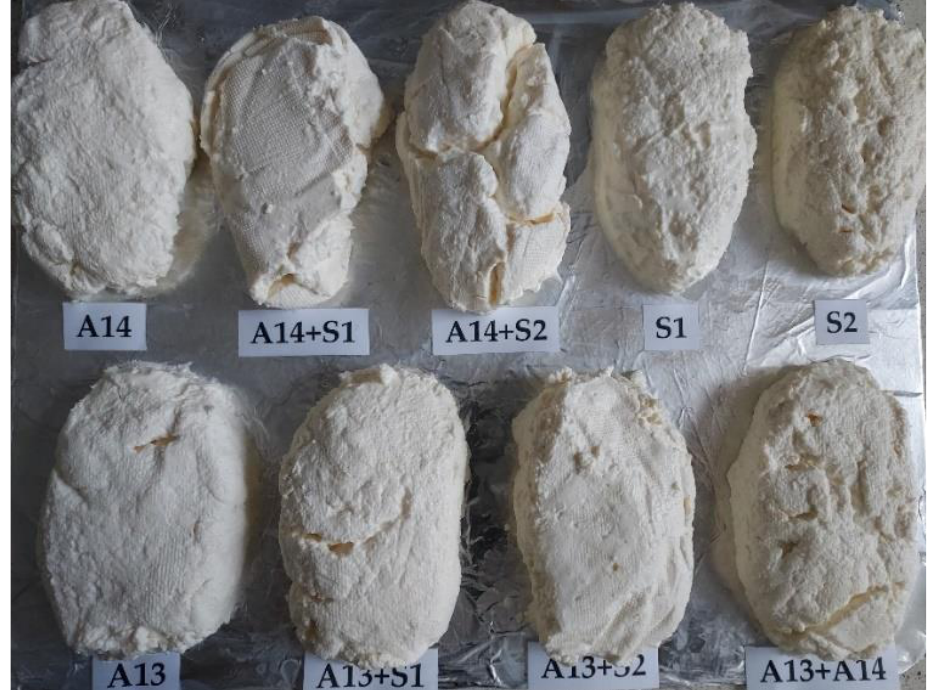
Figure 4. Photograph of cottage cheeses obtained with the use of L. lactis A13 and A14, commercial starter cultures S1 and S2 and their blends. Symbols as in Figure 4.